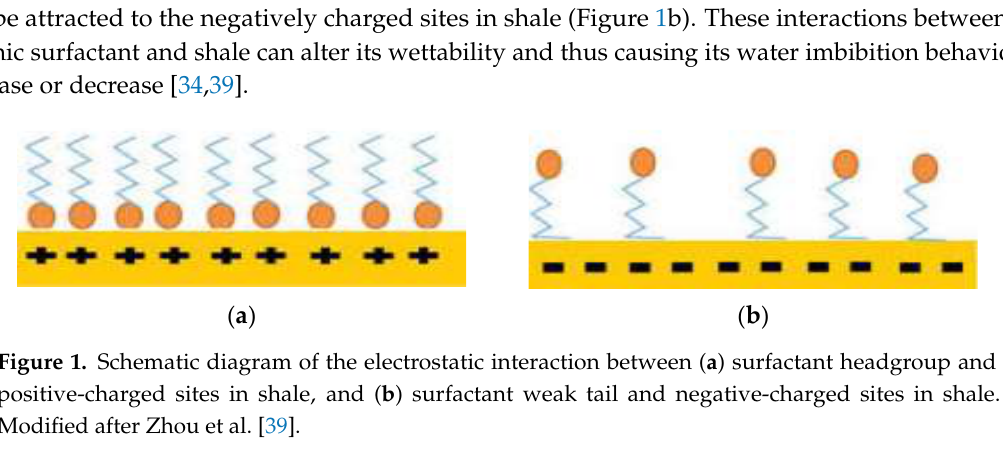
Table 1. Properties of the BG-2 and KH-2 shales.